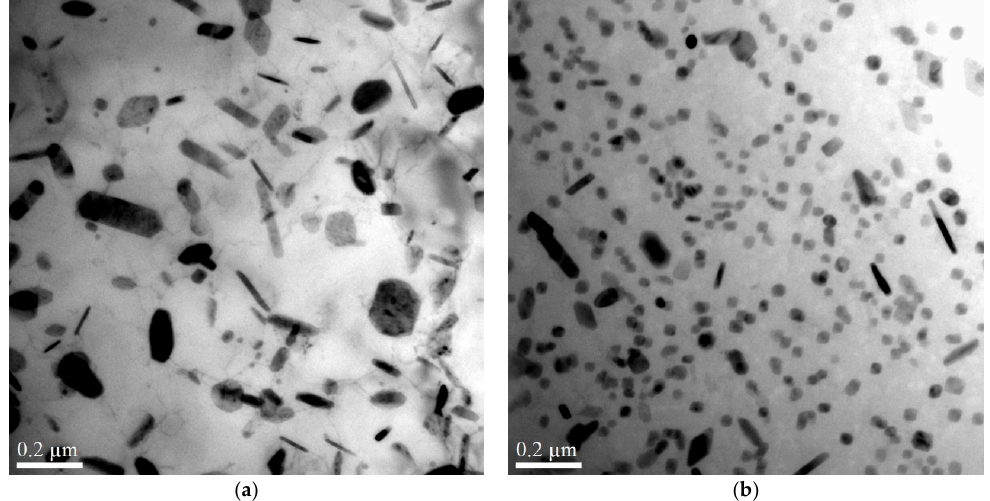
Figure 11. TEM images of dispersoids after holding at 350 °C for 500 h in ( a ) DU0 alloy and ( b ) DU120 alloy.